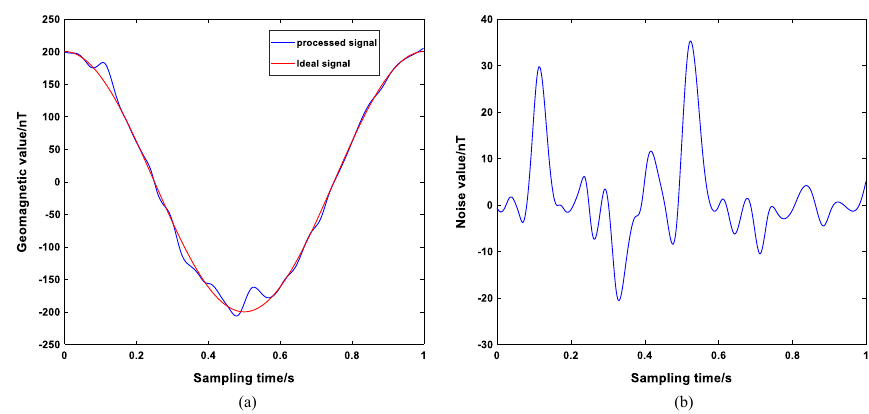
Fig. 11 Signal processing results of Li Ji’s